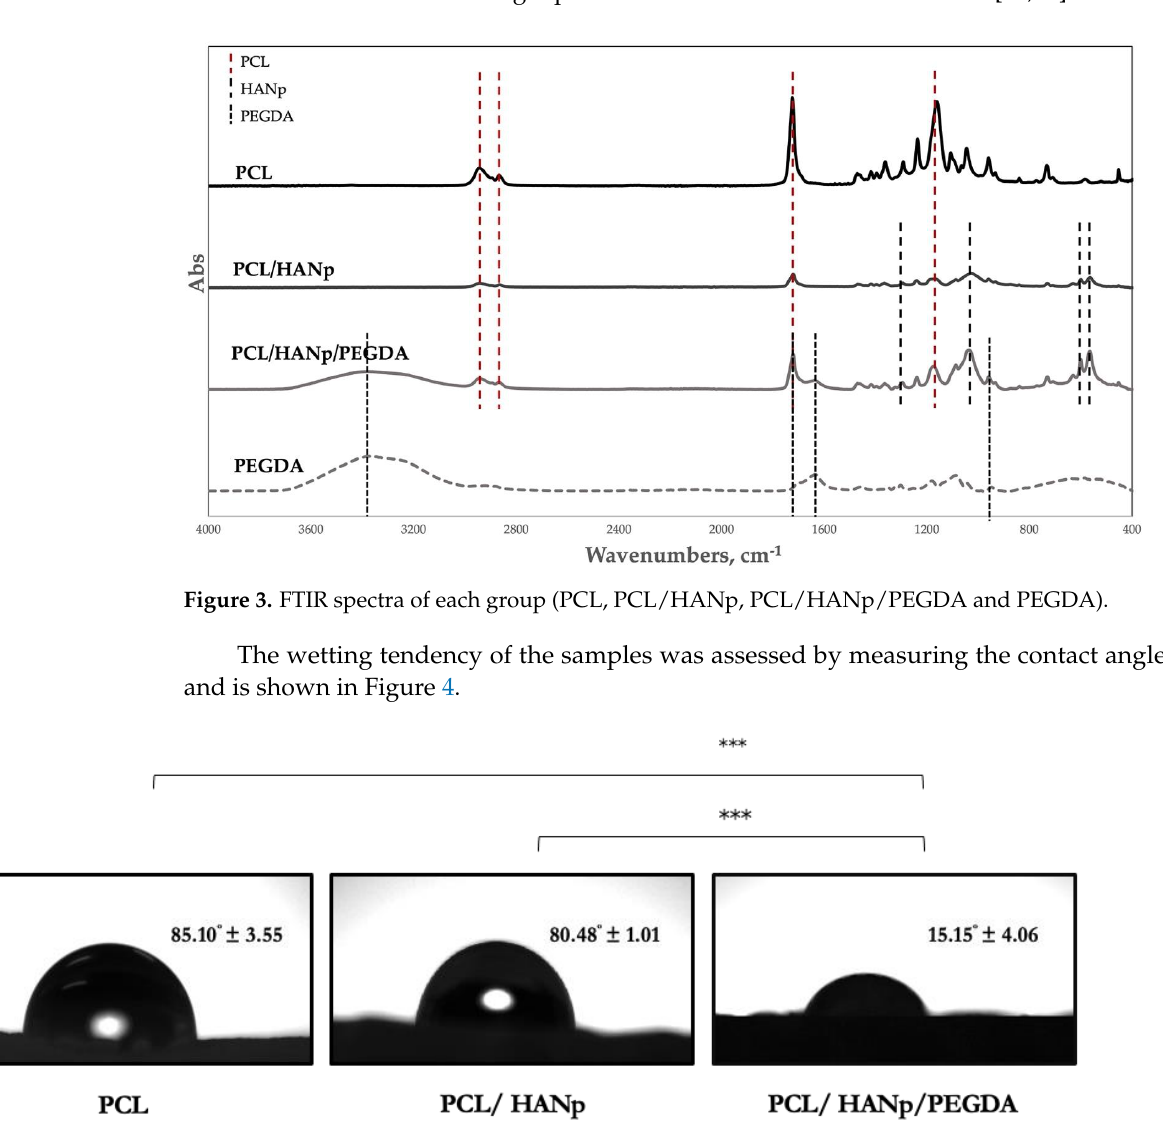
Figure 4. Contact angle measurements mean ± standard deviation of PCL, PCL/HANp and PCL/HANp/PEGDA scaffolds. Differences were considered statistically significant at p ≤ 0.05. Results’ significance is presented through the symbol (*), according to the p value, with three symbols, corresponding to 0.0001 < p ≤ 0.001.